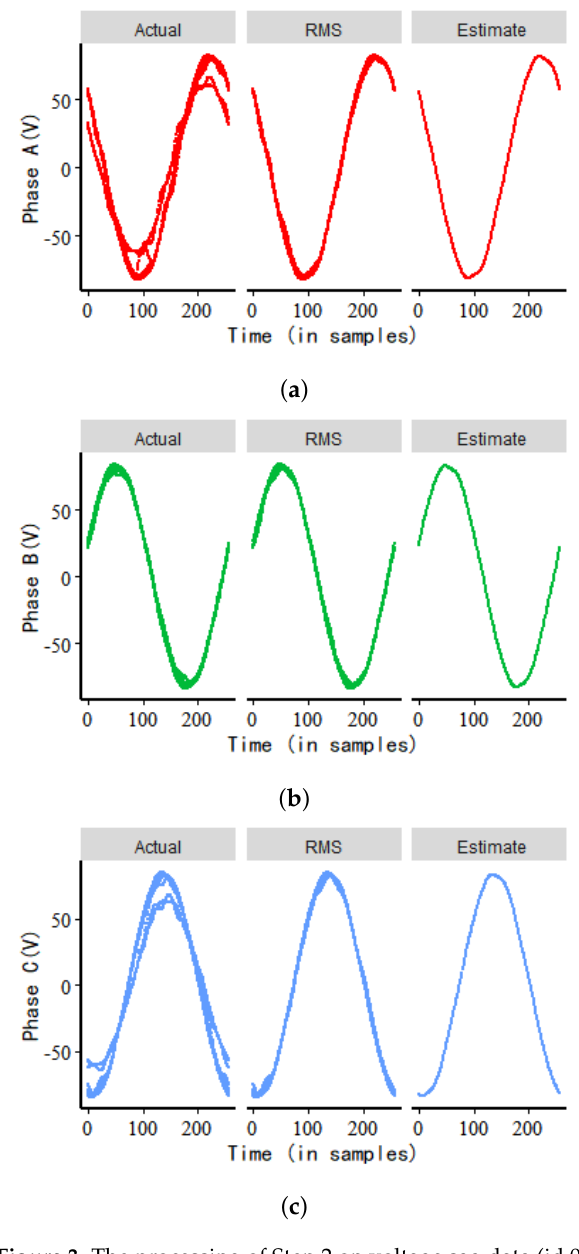
Figure 3. The processing of Step 2 on voltage sag data (id 01), where “Actual” represents the actual response, “RMS” represents the real data after passing the RMS detection, “Estimate” represents ˆ x l , l = 1,2, · · · , K , and the subfigures ( a – c ) represent the three-phase voltage sag data